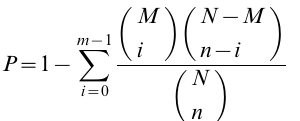
Table S3 SNPs and the blastx results of genes related to growth and reproduction. Table S4 Resistant strain selection